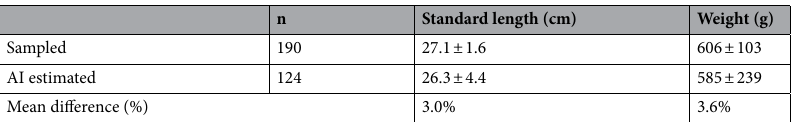
Table 1. Field and AI measurements of mean fish standard length and weight. Mean differences are calculated as the percentage between the two different approaches.